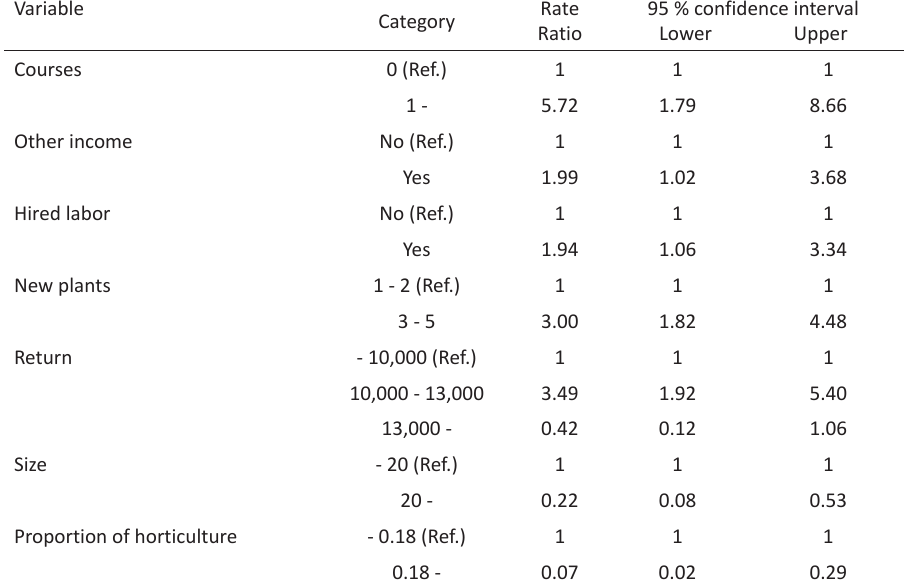
Table 2. Rate ratios (“relative risks”) of the probability of interest in organic production according to the final model resulting from stepwise selection Variable